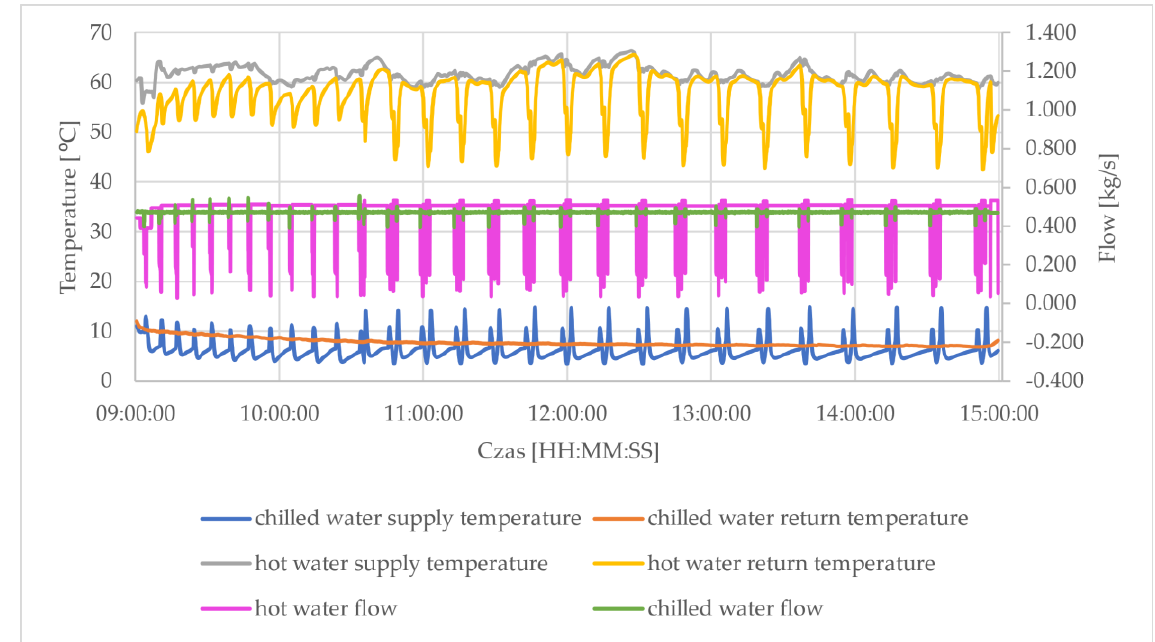
Figure 12. Measured values of temperatures and flow rates over time for 31st July.